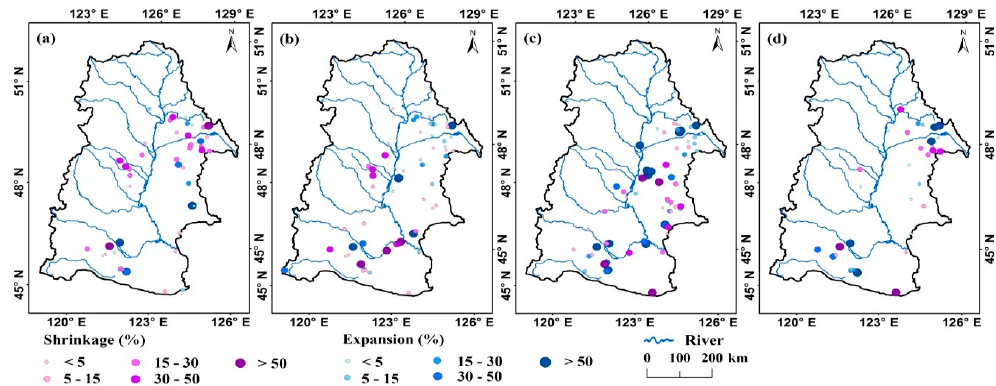
Figure 7. Spatial distribution of reservoir changes in the Nenjiang watershed during different periods. Purple and blue dots present reservoir shrinkage and expansion, respectively, while the dot extent denotes change proportion in the corresponding period. ( a )–( d ) represent the periods 1980–1990, 1990–2000, 2000–2010, and 2010–2015, respectively.